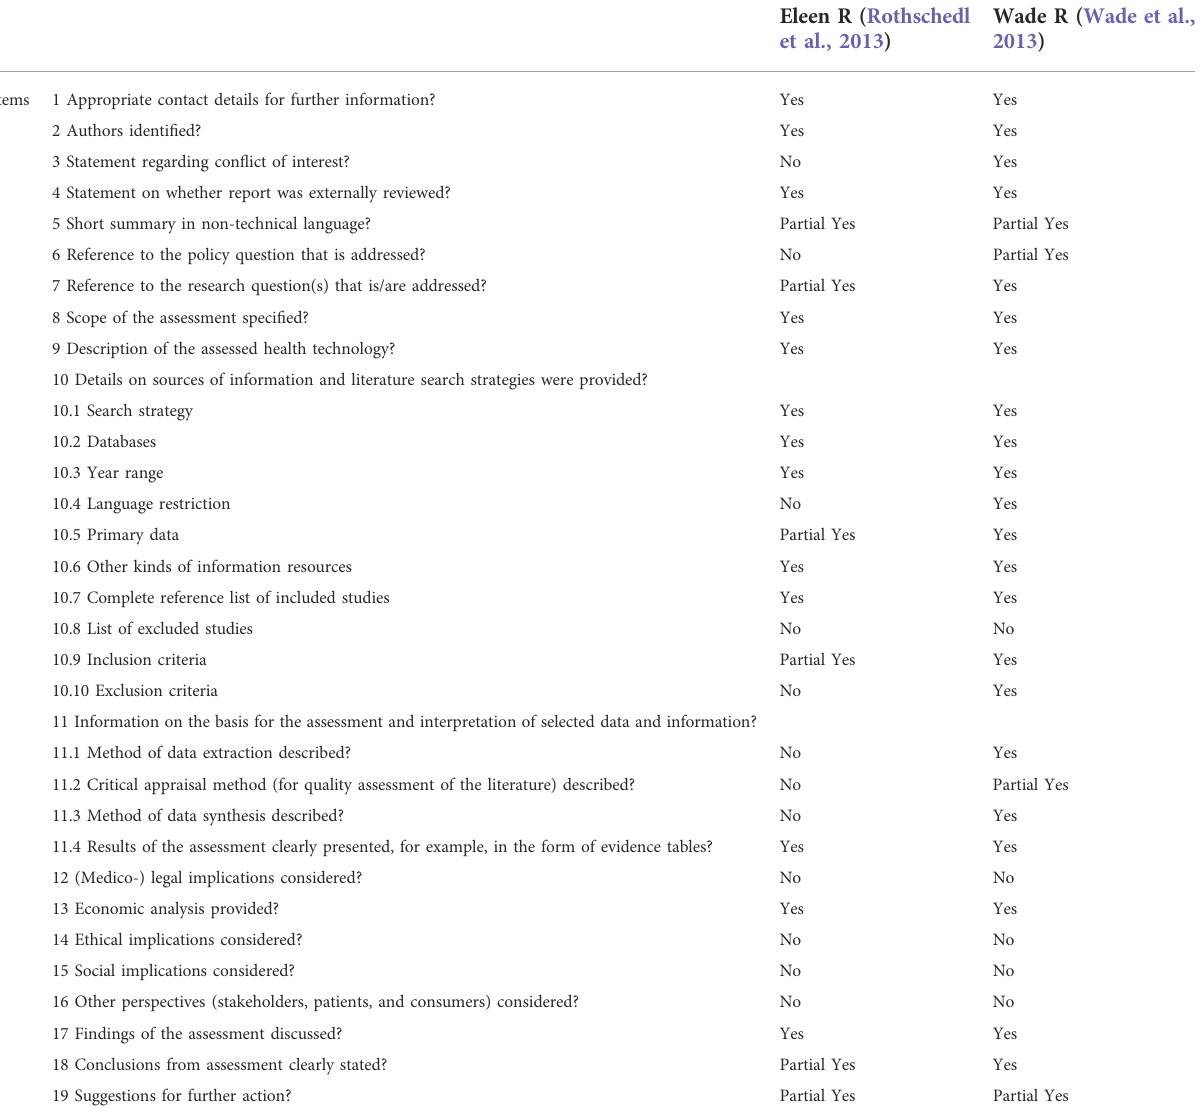
TABLE 5 Quality evaluation of included